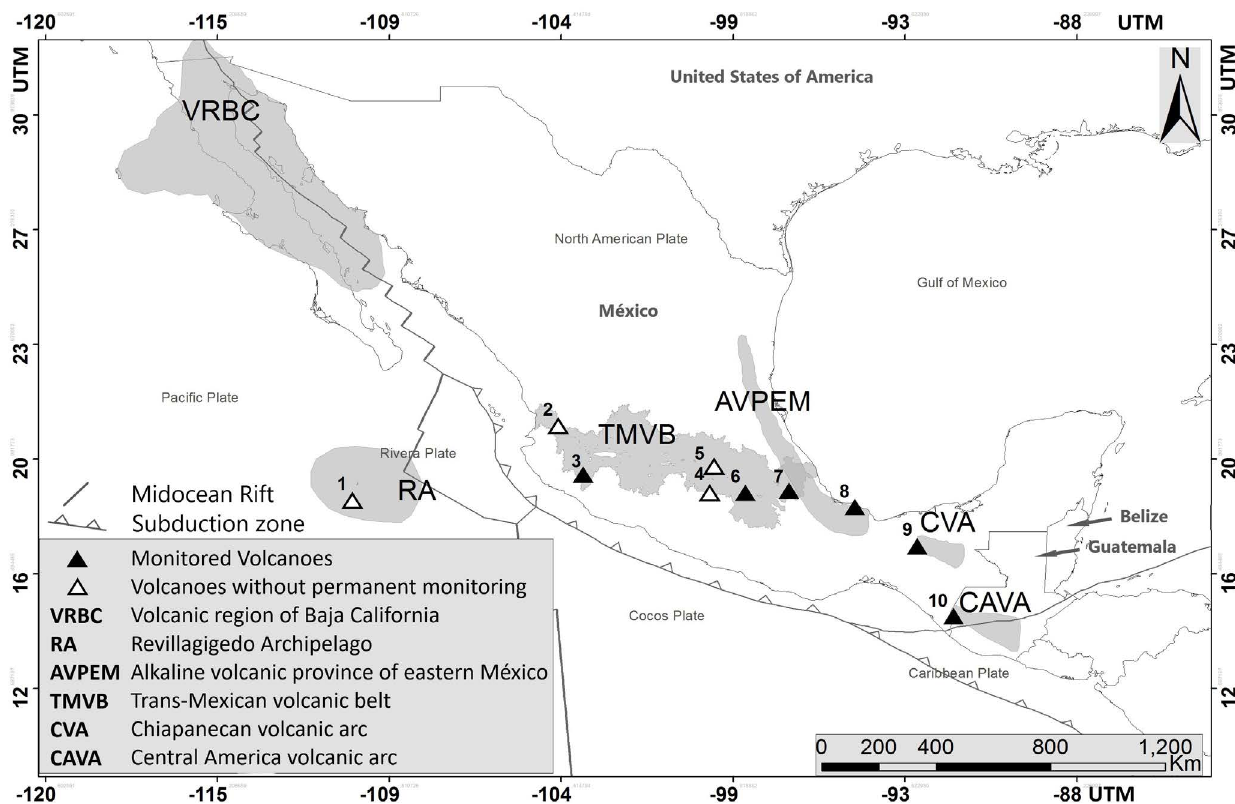
Figure 1: Tectonic setting of Mexico and the different volcanic provinces (grey regions). Main volcanoes men- tioned in text: 1) Evermann, 2) Ceboruco, 3) Colima, 4) Nevado Toluca, 5) Jocotitlán, 6) Popocatépetl, 7) Citlaltépetl, 8) San Martín Tuxtla, 9) Chichón and 10)